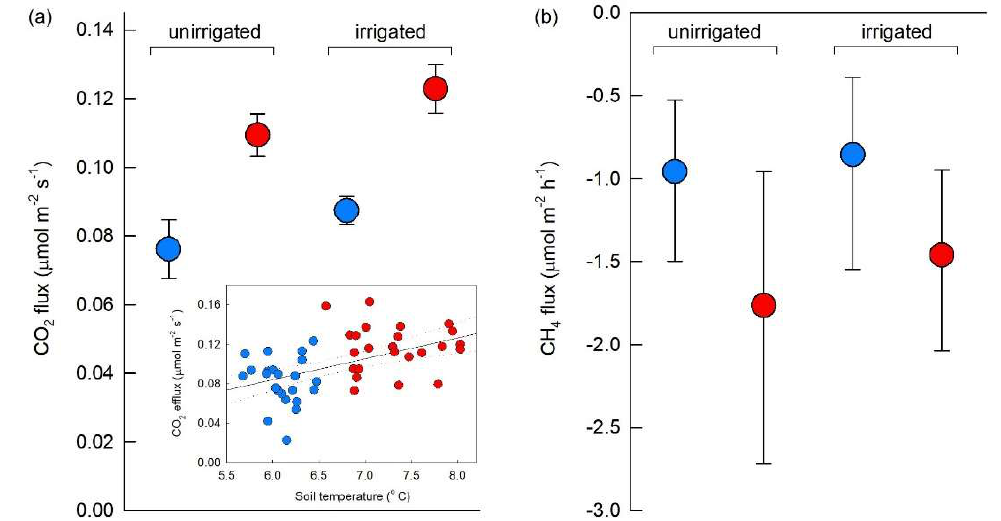
Figure 3. Fluxes to and from soil of ( a ) CO 2 and ( b ) CH 4 . Note that positive fluxes in ( a ) and negative fluxes in ( b ) indicate the release of CO 2 from soil and consumption of CH 4 by soil, respectively. Values are means of 12 replicates, with bars in ( a , b ) showing SEM and 95% bootstrap confidence intervals, respectively. Note that y -axes are scaled differently. Inset in ( a ) shows soil CO 2 efflux as a function of soil temperature measured during sampling, with the solid line denoting the best linear fit and the dotted lines denoting 95% confidence intervals. See key in Figure 2a for treatment notation.